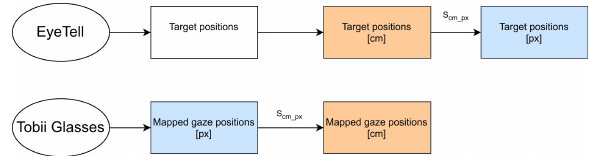
Figure 4. An overview of the EyeTell and eye-tracking data processing with the unit conversions. The blue boxes depict the target and gaze positions in pixels, and which are used for smooth-pursuit onset detection process. The orange boxes depict the target and gaze positions in cm, and which are used to compute the smooth-pursuit performance